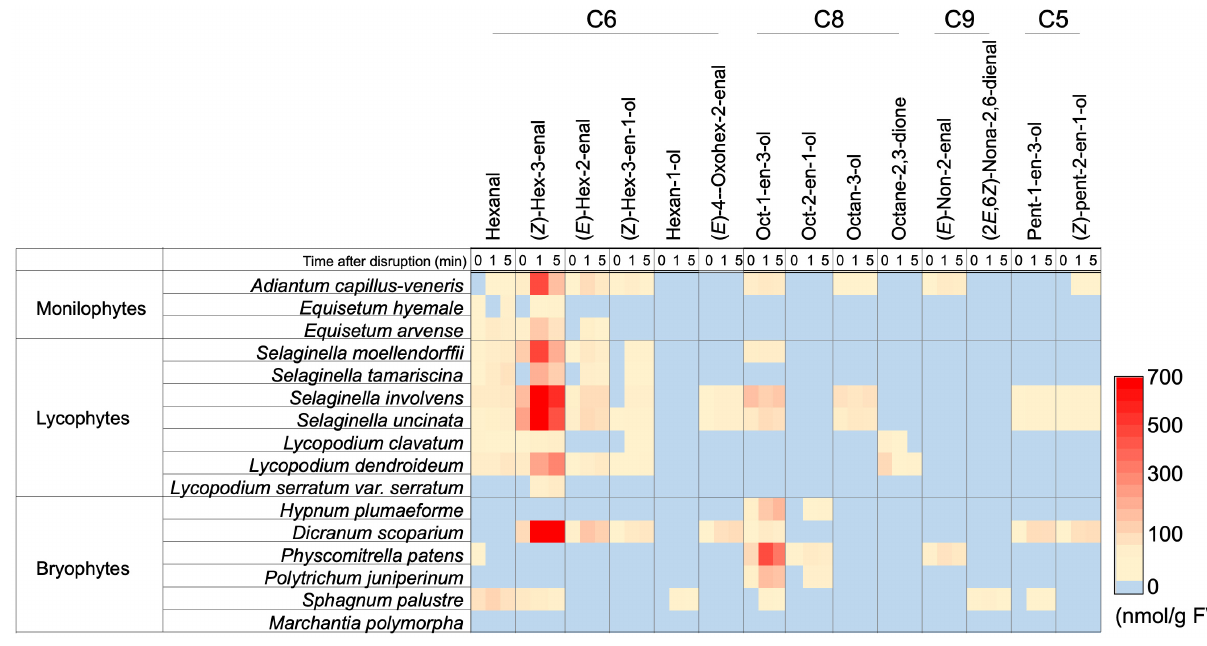
FIGURE 3 | Distribution of the ability to form oxylipin volatiles among a subset of monilophyte, lycophyte, and bryophyte plant species. The amount of each compound is shown with color. The detailed values are shown in Supplementary Dataset 1